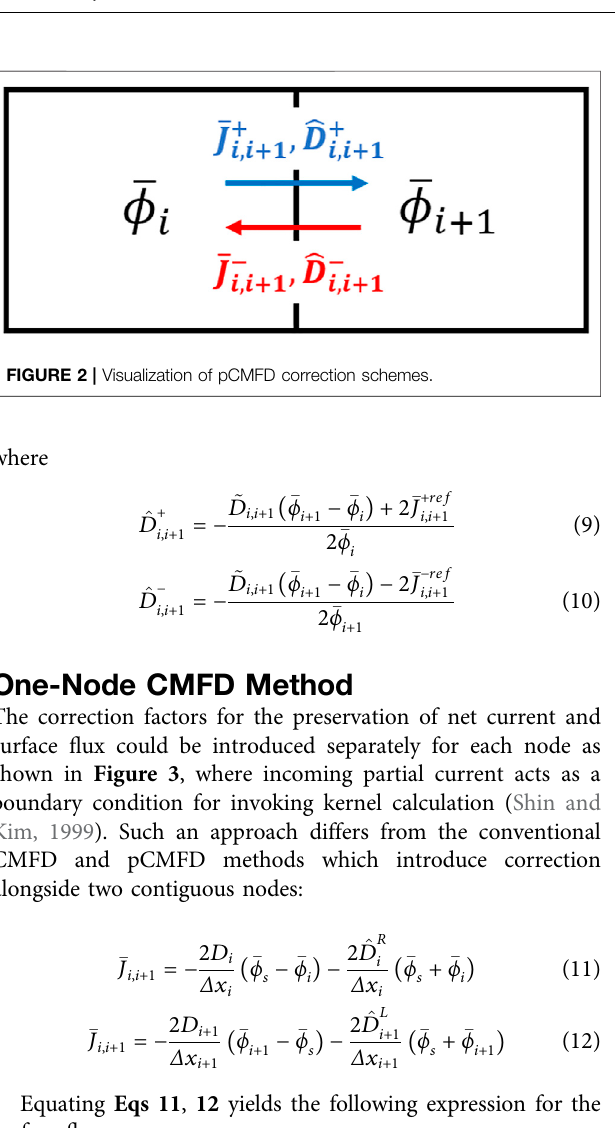
FIGURE 1 | Balance within a node of interest.